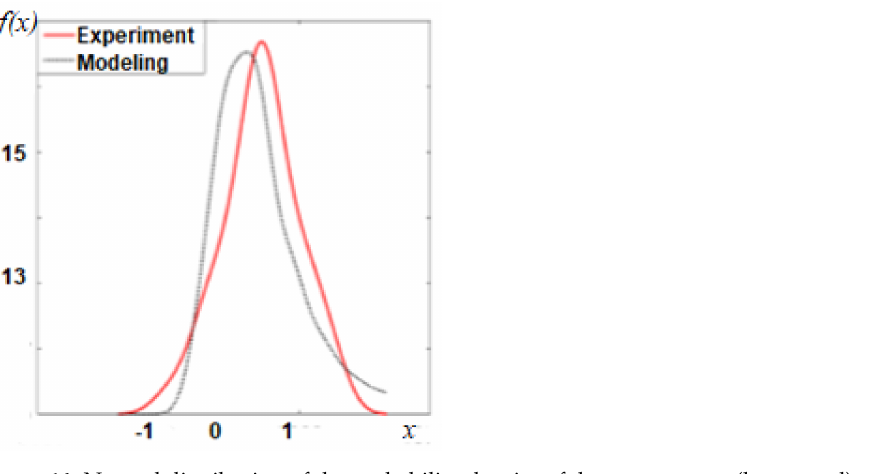
Figure 14. Normal distribution of the probability density of the temperature